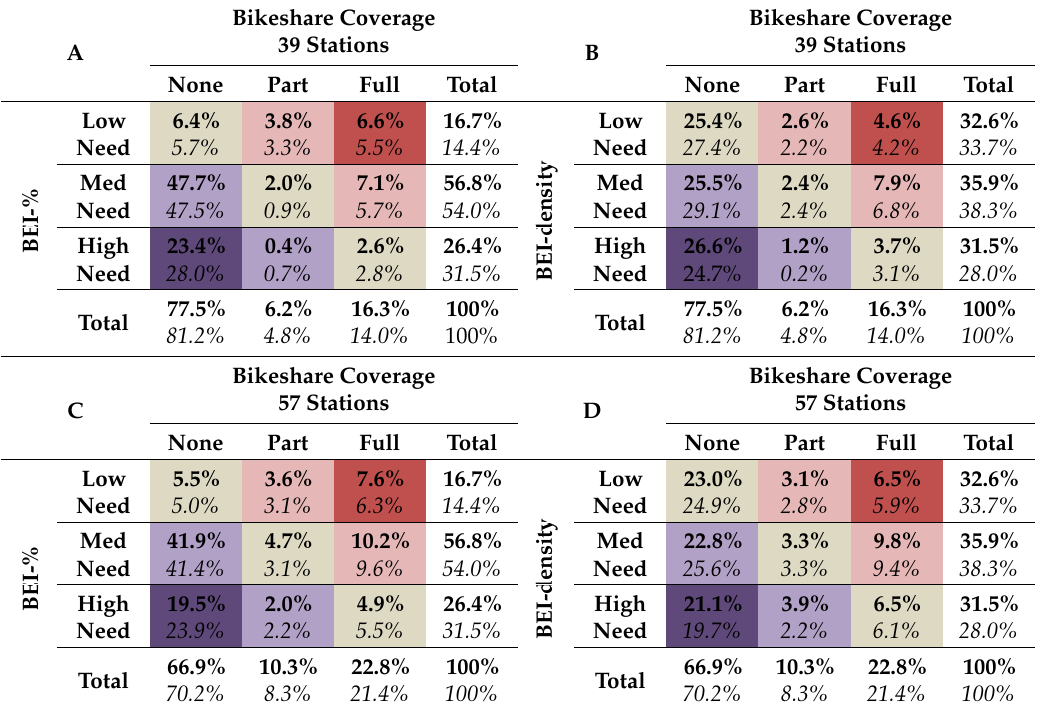
Table 1. Comparison of Bike Equity Indices and Bike Share Station Coverage by Percent of Population (bold) and Percent of Census Block